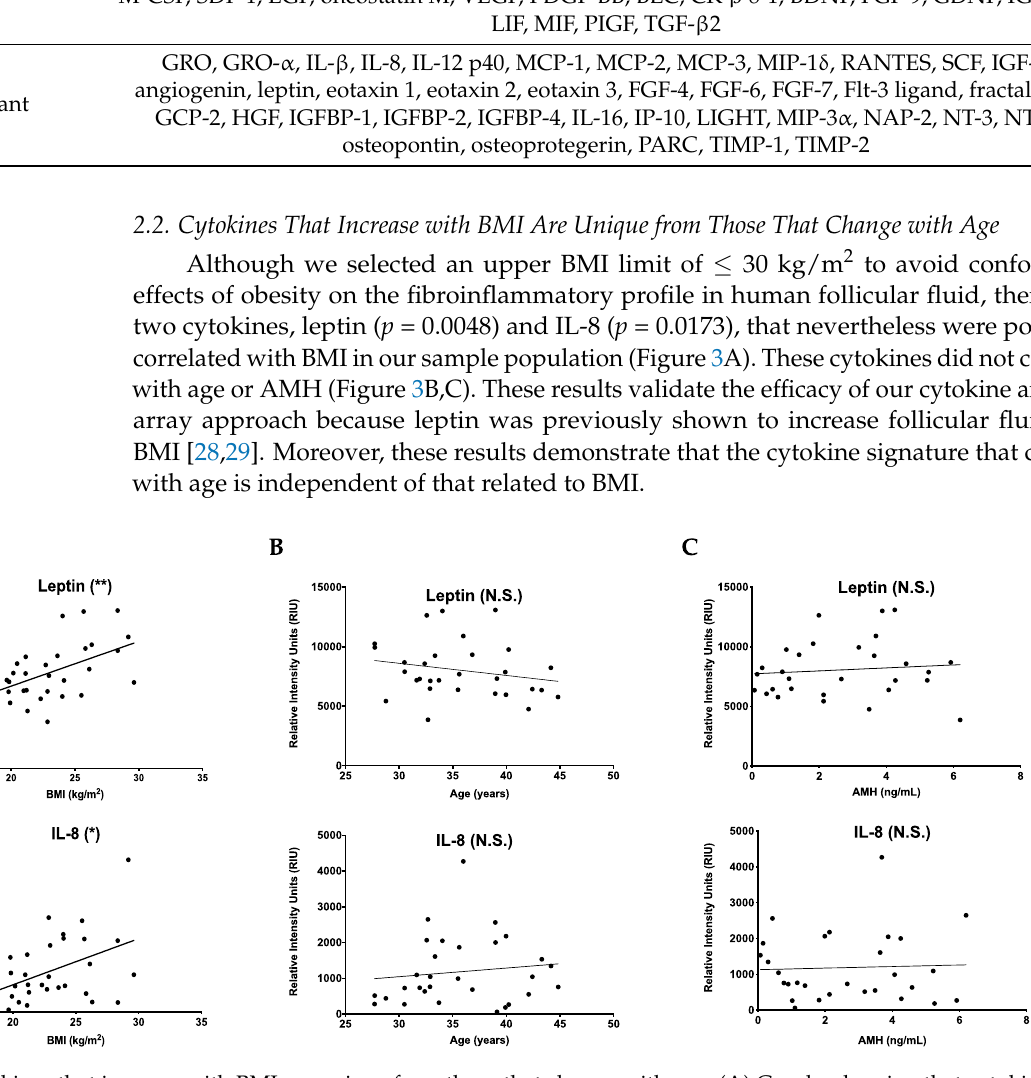
Figure 3. Cytokines that increase with BMI are unique from those that change with age. ( A ) Graphs showing that cytokines leptin and IL-8 were significantly correlated with increasing BMI (kg/m 2 ). ( B ) Graphs showing that leptin and IL-8 did not significantly change with increasing age. ( C ) Graphs showing that leptin and IL-8 did not significantly change with increasing AMH. The lines correspond to the fitted regression equation. * p < 0.05, ** p < 0.01, N.S. = no statistical significance.